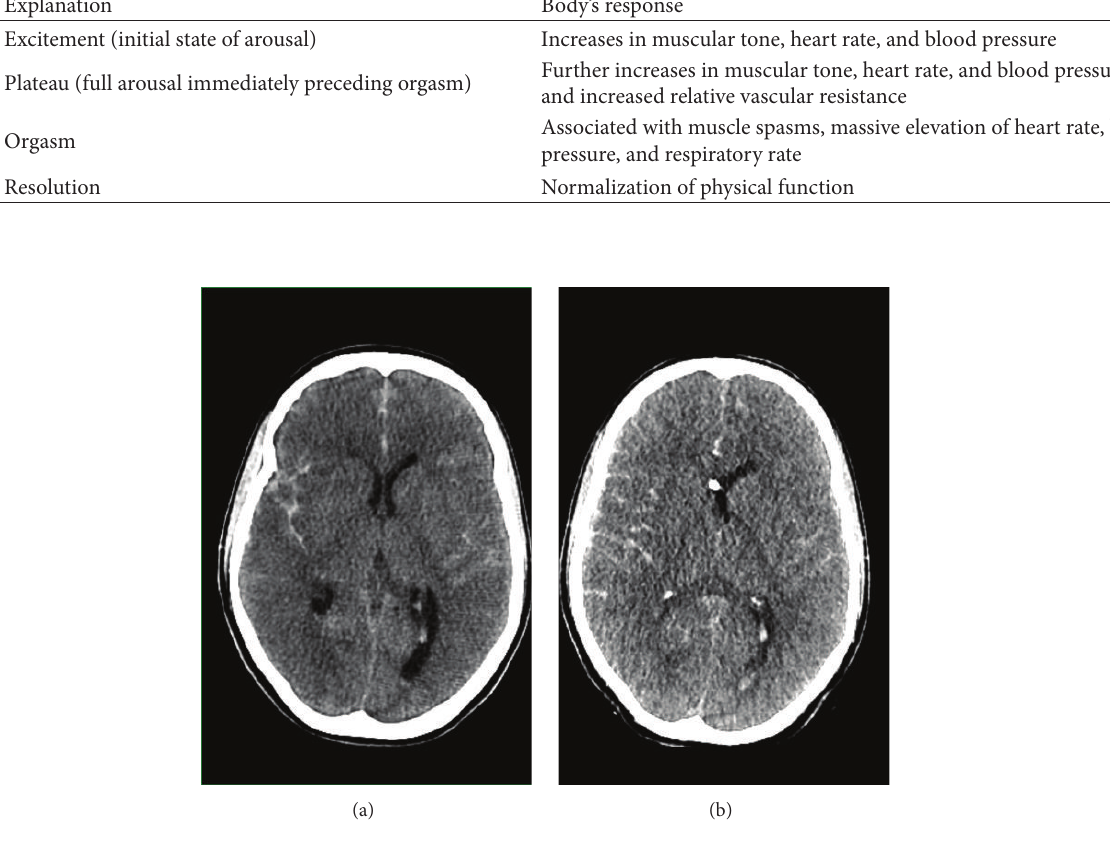
Figure 1: (a) First computed tomography of the head (01:25 am) and (b) follow-up computed tomography of the head (02:30